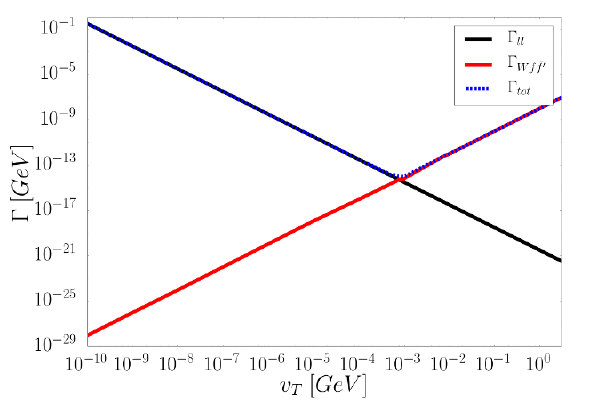
Figure 3 . Total decay width of the doubly charged scalar (cid:12)eld H (cid:6)(cid:6) as a function of the triplet VEV v T for m = 130 GeV (blue). Red and black lines are partial decay widths for H (cid:6)(cid:6) H (cid:6)(cid:6) and H (cid:6)(cid:6) W (cid:6) ( W (cid:6) ) (cid:3) W (cid:6) ff 0 respectively. ! !